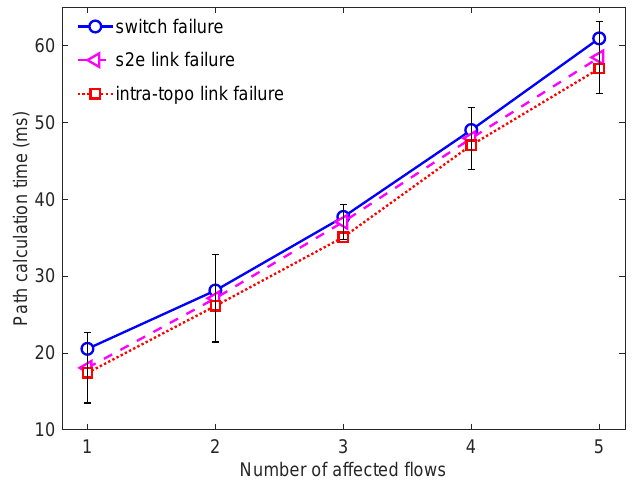
Figure 7. Path calculation time of different